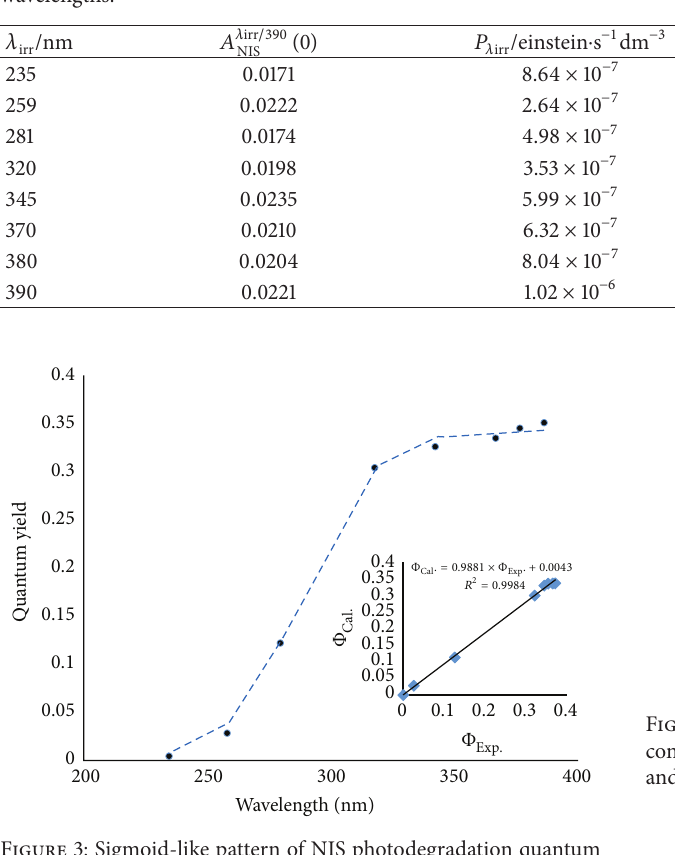
Figure 3: Sigmoid-like pattern of NIS photodegradation quantum yield values with irradiation wavelength. Inset: experimental ( Φ 𝜆 irr Exp . ) versus calculated ( Φ 𝜆 irr Cal . ) quantum yield values.